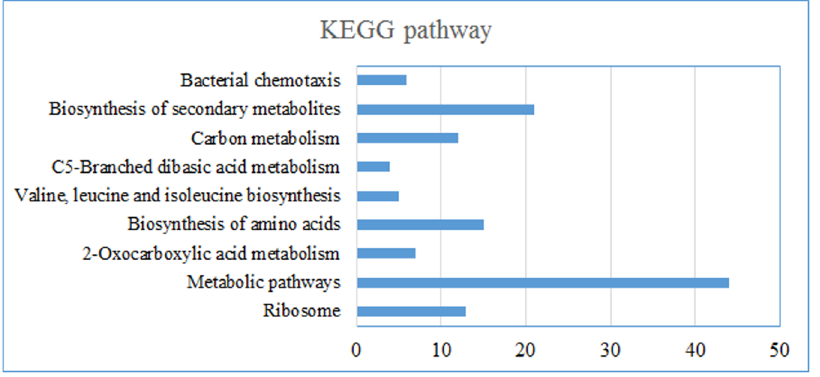
Fig 3. The KEGG pathways in statistically significant differentially expressedproteins of P . aeruginosa obtained by iTRAQ and label-based methodology.